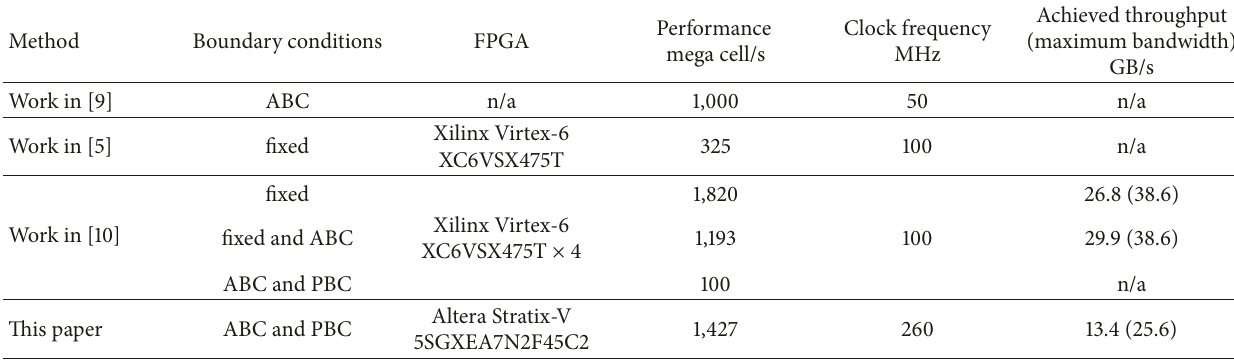
Table 4: Comparison with other FPGA accelerators for 3D FDTD with boundary conditions.